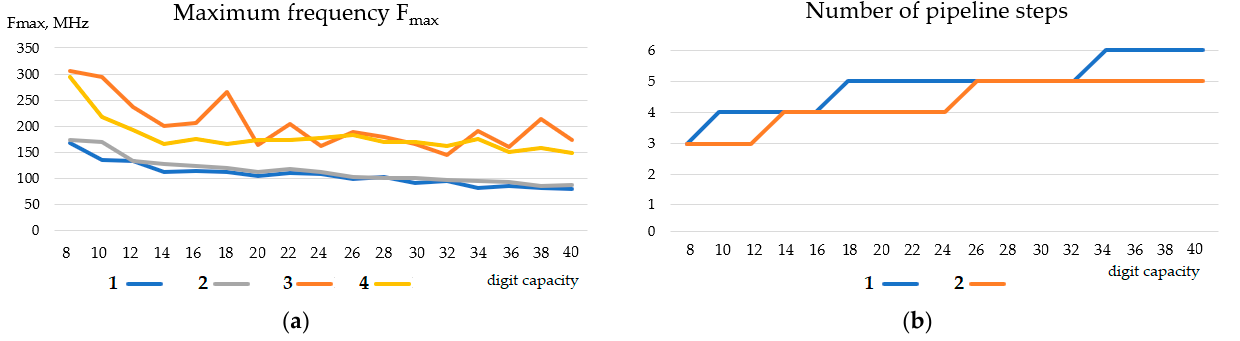
Figure 13. Comparison of pipeline implementations of multipliers: ( a ) comparison of the maximum frequency, ( b ) comparison of the pipeline depth. Figure shows the frequencies for the combinatorial implementation of constant multiplication: 1—by Booth’s algorithm; 2—by the proposed algorithm and the pipelined constant multipliers; 3—by Booth’s algorithm; and 4—by the proposed algorithm. We also compared the considered solutions with the characteristics of the devices